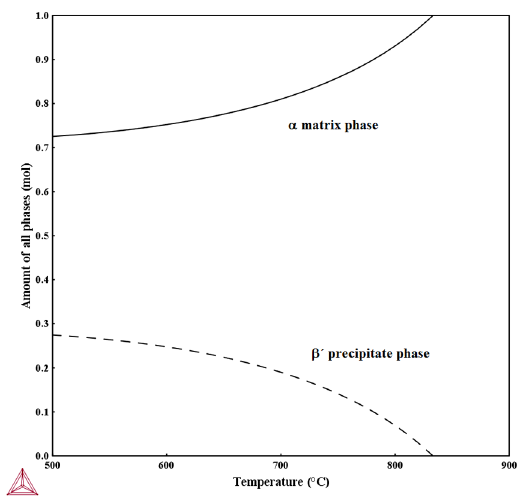
Figure 4. Thermo-Calc calculated plot of amount of all phases versus